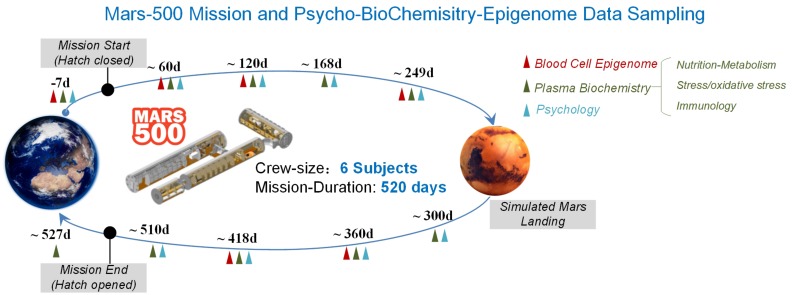
Testing schedule of simulation experiment and biochemical changes in the MARS500 mission. Schematic diagram of the Mars-500 simulation space flight mission. Vertical arrowheads represent the time points of data sampling points, which are distributed over the whole flight mission. Colored triangles showed the testing time points for psychology, plasma biochemistry and blood cell DNA methylation profiling, respectively. The timepoints occupy the whole simulation process from pre-isolation, during isolation (traveling to Mars, landing on Mars and returning back to earth) and post-isolation phases.